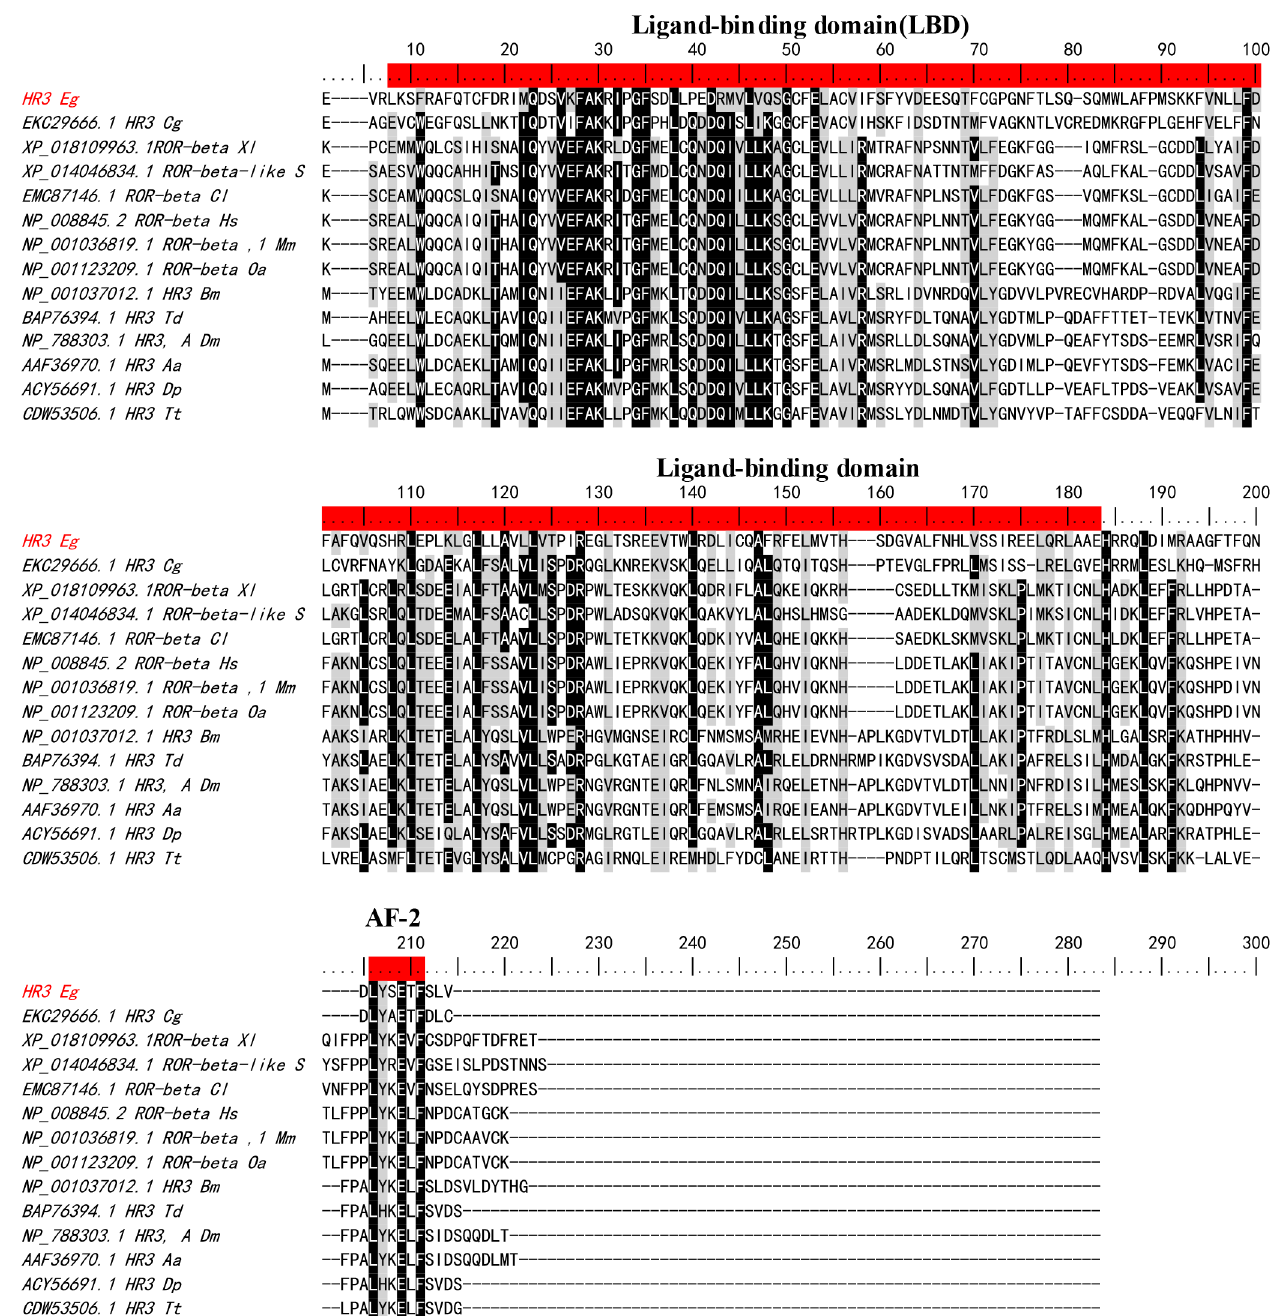
Figure 2. Sequence alignment of the ligand-binding domain (LBD) of E. granulosus EgHR3-like protein with the LBD from other species. The two conserved motifs and the putative autonomous activation domain (AF-2) are highlighted in red. Sequences used for alignment are shown in Table